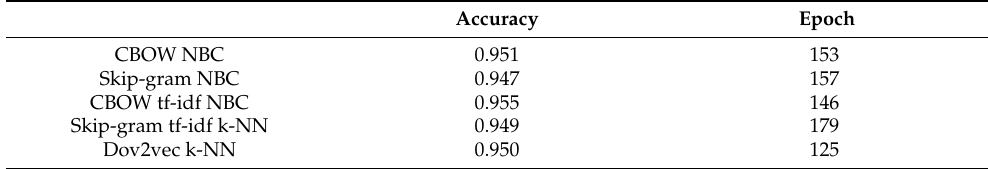
Table 4. Accuracy of Naive Bayesian Classifier classification for different vectorization methods.